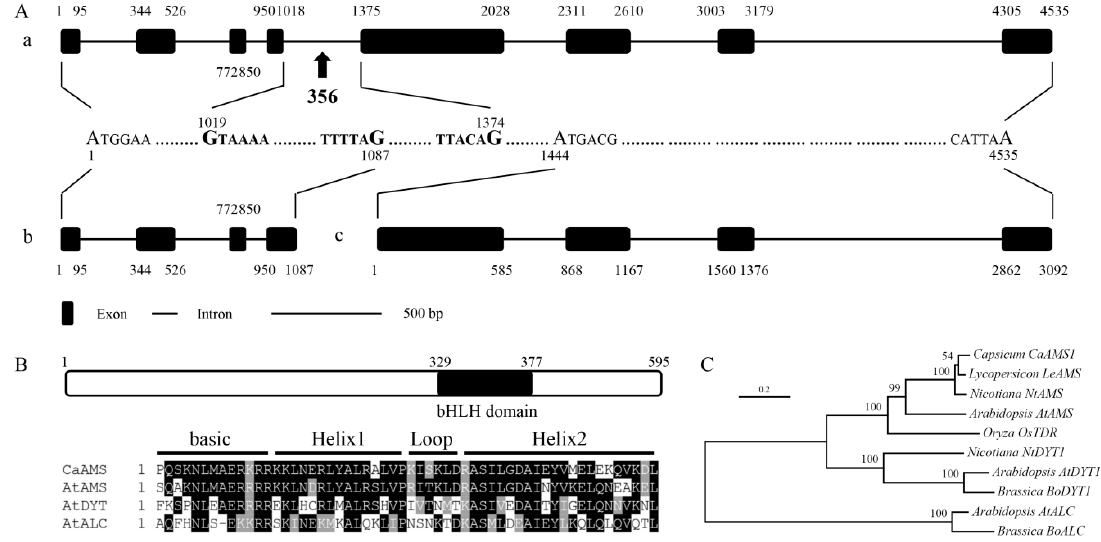
Figure 1. Sequence analysis of CaAMS . ( A ) Exon-intron structure of CaAMSs . a–c indicate the exon-intron structures of CaAMS1 , CaAMS2-1 , and CaAMS2-2 , respectively. Black boxes indicate exons; Connecting lines indicate introns; Letters in bold indicate the fourth introns inserted; Capital letters indicate the starting and stopping nucleotides. ( B ) Predicted protein structure of CaAMS1 and sequence alignment of the bHLH domain. The black region indicates the bHLH domain. ( C )